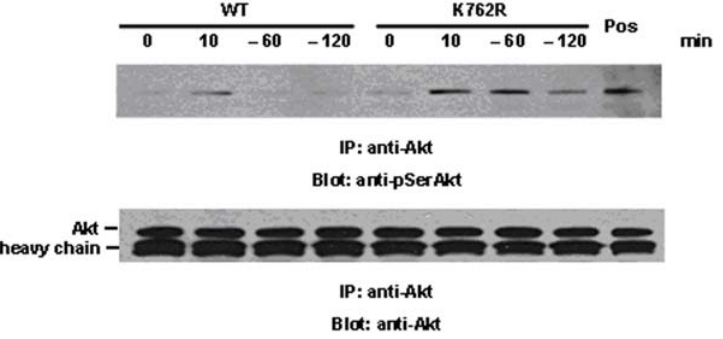
Figure 6. Prolonged Akt activation in response to G-CSF in BaF3 cells transfected with the K762R/G-CSFR. BaF3 cells stably transfected with either the WT G-CSFR or K762R/G-CSFR were washed and incubated in cytokine-free media (RPMI/0.1%BSA) at 37 u C for 4 hrs. Cells were then treated with G-CSF (100 ng/ml) at 37 u C for 10 min, washed, incubated in cytokine-free media again for the indicated times, and lysed. Whole cell lysates were immunoprecipitated with anti-Akt antibody, and blotted with anti-phospho-Ser-Akt antibody (upper panel). The blot was stripped and re-blotted with anti-Akt antibody to confirm equal protein loading (lower panel). Cells stimulated with activated orthovanadate at room temperature for 20 min are shown as a positive